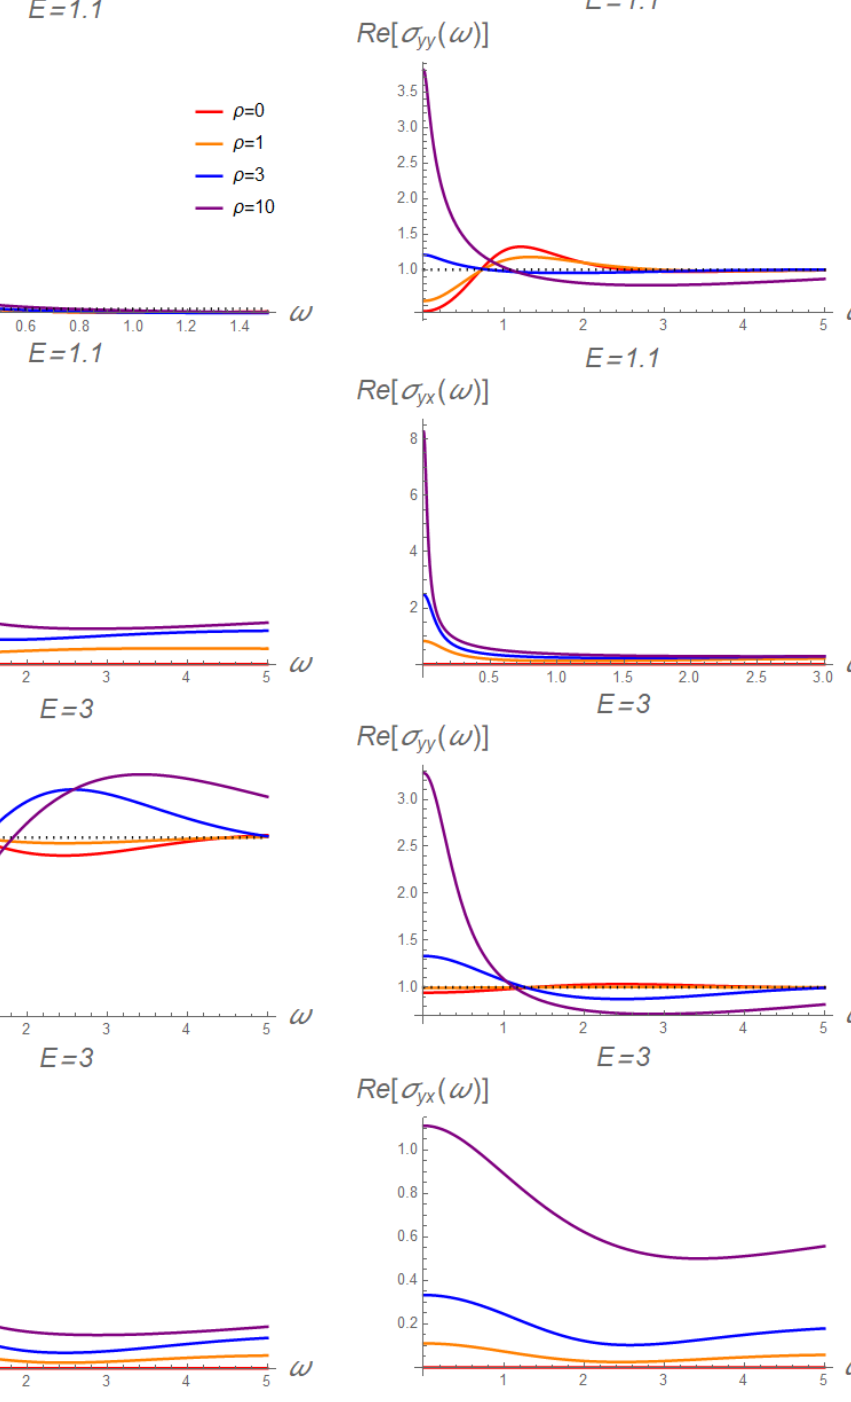
Figure 3 . Real parts of the conductivities for di(cid:11)erent values of electric (cid:12)eld E and charge density (cid:26) .